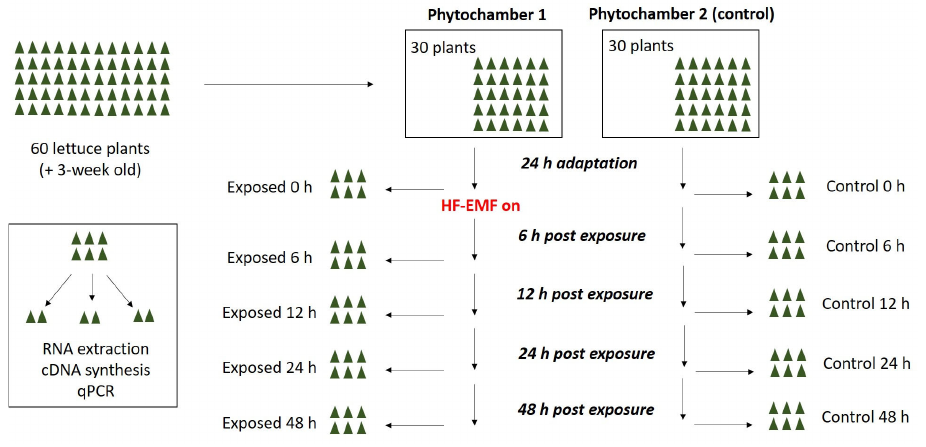
Figure 9. Experimental plan—expression analysis of stress genes ZEP and VDE under RF-EMF ex ‐ posure.